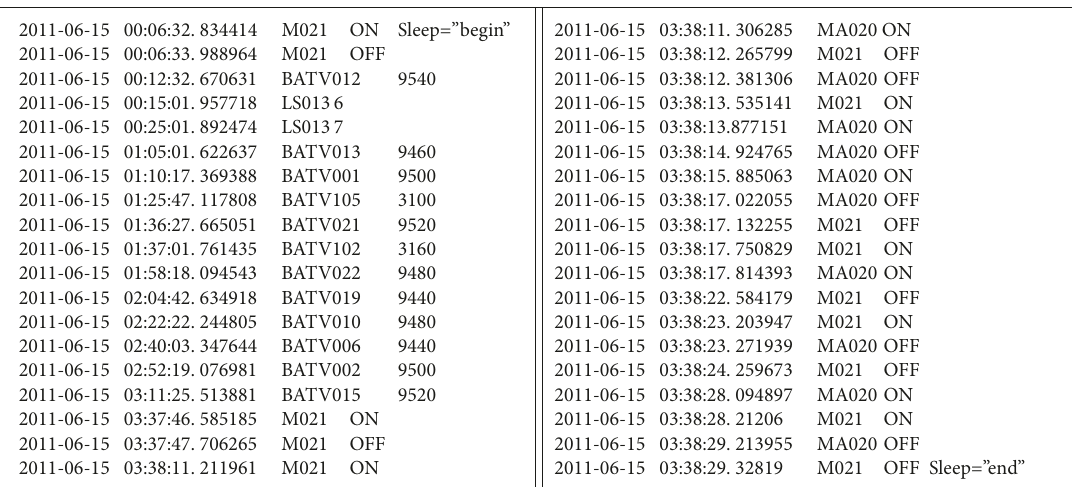
Figure 2: Activated sensor events stream on activity